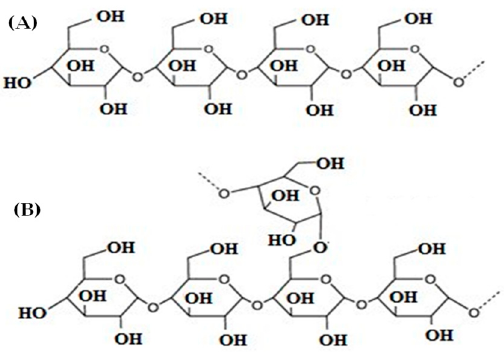
Figure 1. The molecular structure of amylose ( A ) and amylopectin ( B ).